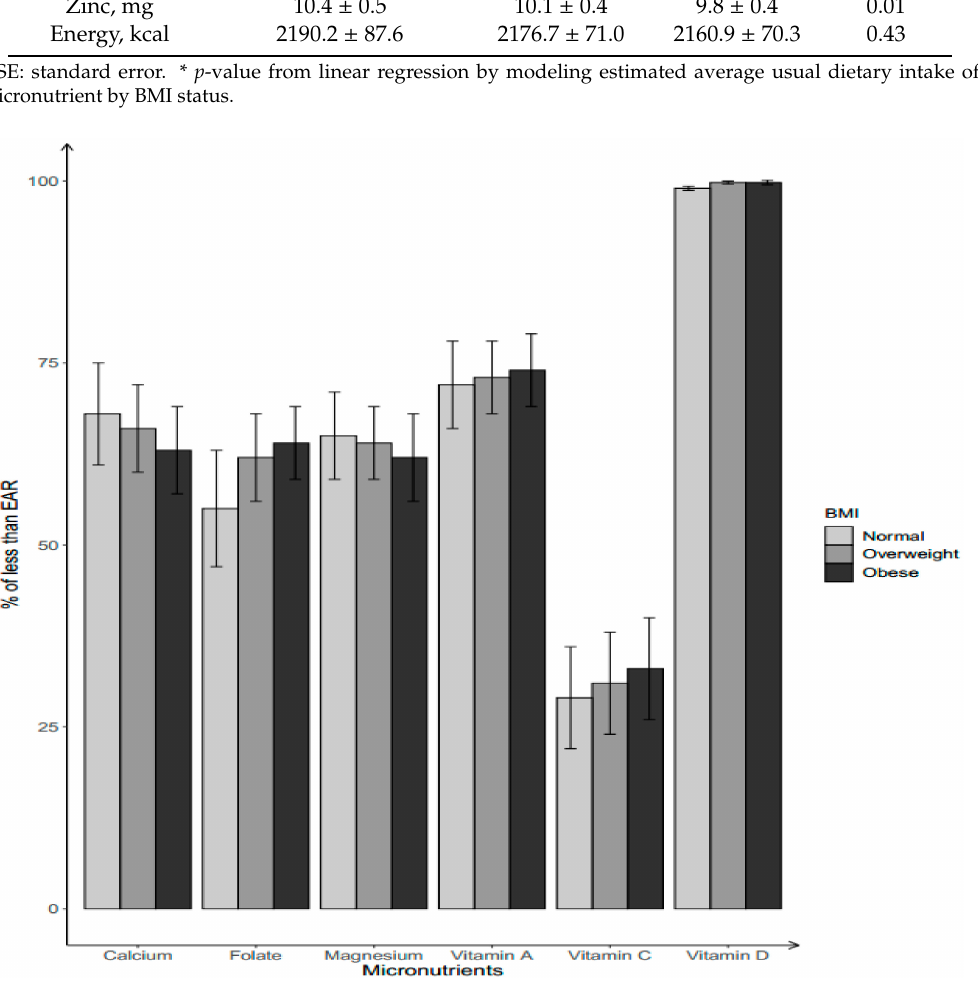
Figure 2. Percentage of non-Hispanic Black women aged 19–39 years with dietary micronutrient intakes below EARs by body weight status. Body weight status categorized by BMI into three groups: normal / under-weight: BMI ≤ 25.0; overweight: 25.0 < BMI < 29.9; obese: BMI ≥